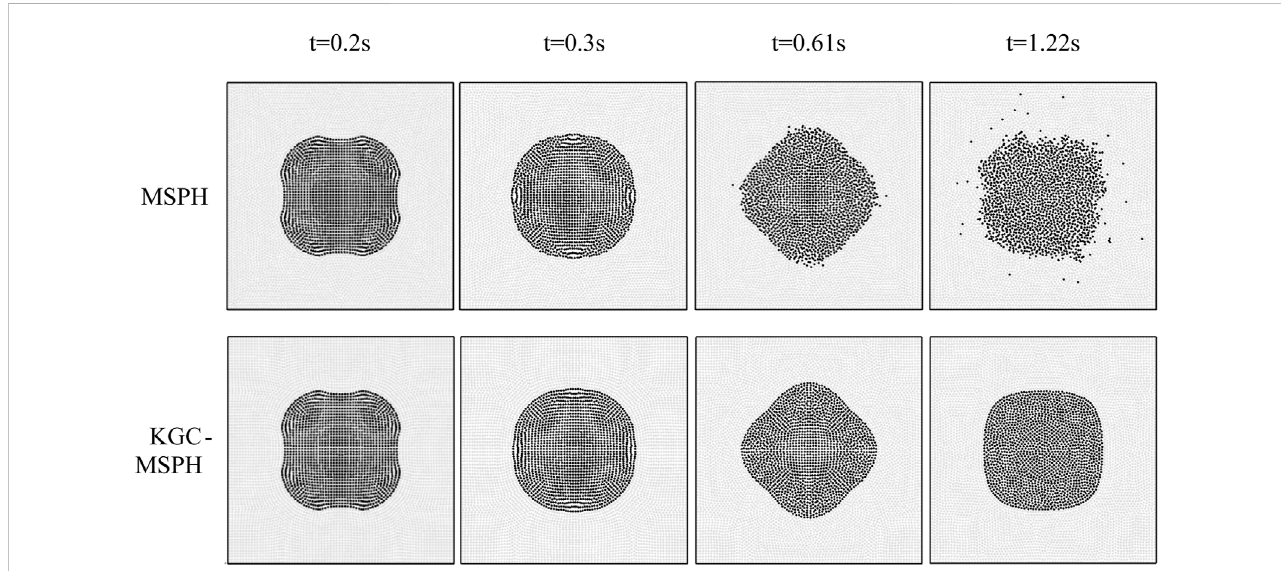
FIGURE 2 Comparison of square droplet oscillation simulated with MSPH and